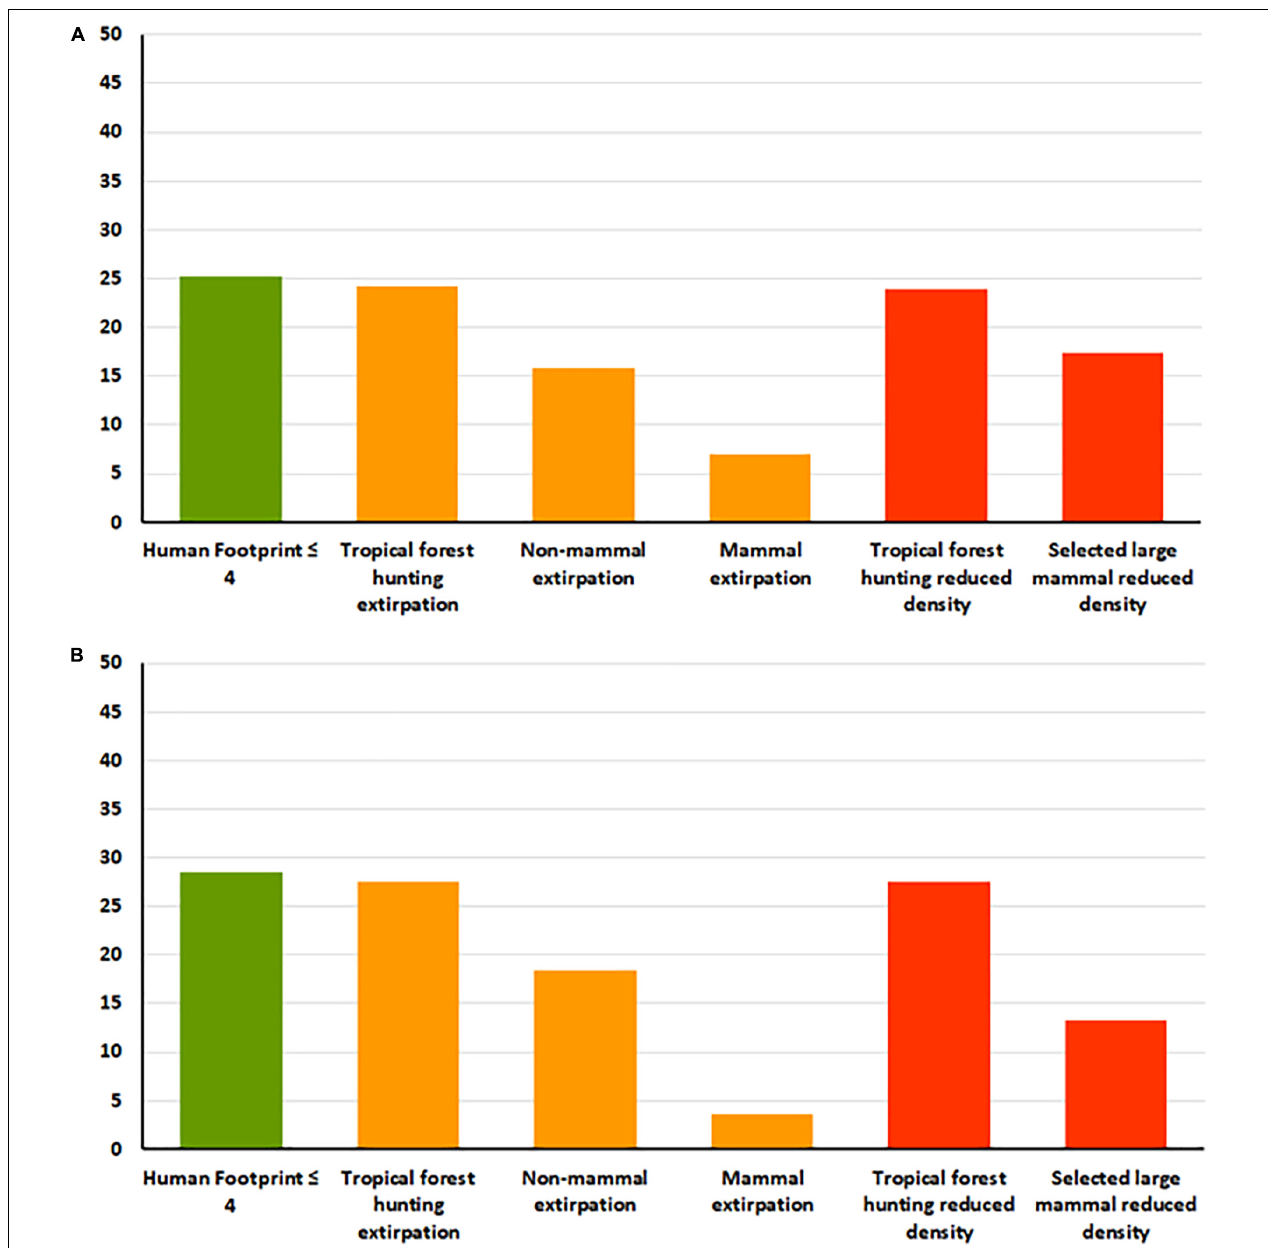
FIGURE 2 | The effects of selecting a HF ≤ 4 (green) on the percentage of (A) ecoregions and (B) area of the land surface of the earth with the addition of three measures of faunal intactness (Orange – Intact fauna in tropical forest; non-mammal extirpations from the IUCN Red List; Mammal extirpations) and two measures of functional intactness (Red – Minimal impacts of hunting in tropical forest; High densities of selected large mammals). The percentages/areas are calculated as the amount remaining as each layer is selected within the HF ≤ 4 layer for polygon areas that are 10,000 km 2 or